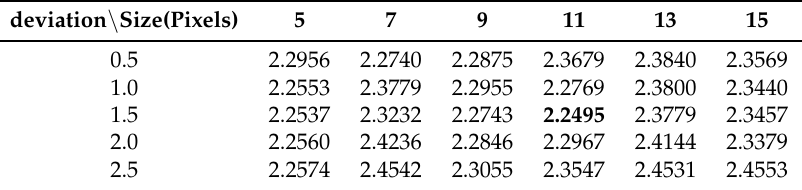
Table 4. The impact of size and deviation of the Gaussian low-pass filter on running time (seconds), which is tested on LIVE II dataset. The minimum running time is marked in boldface.